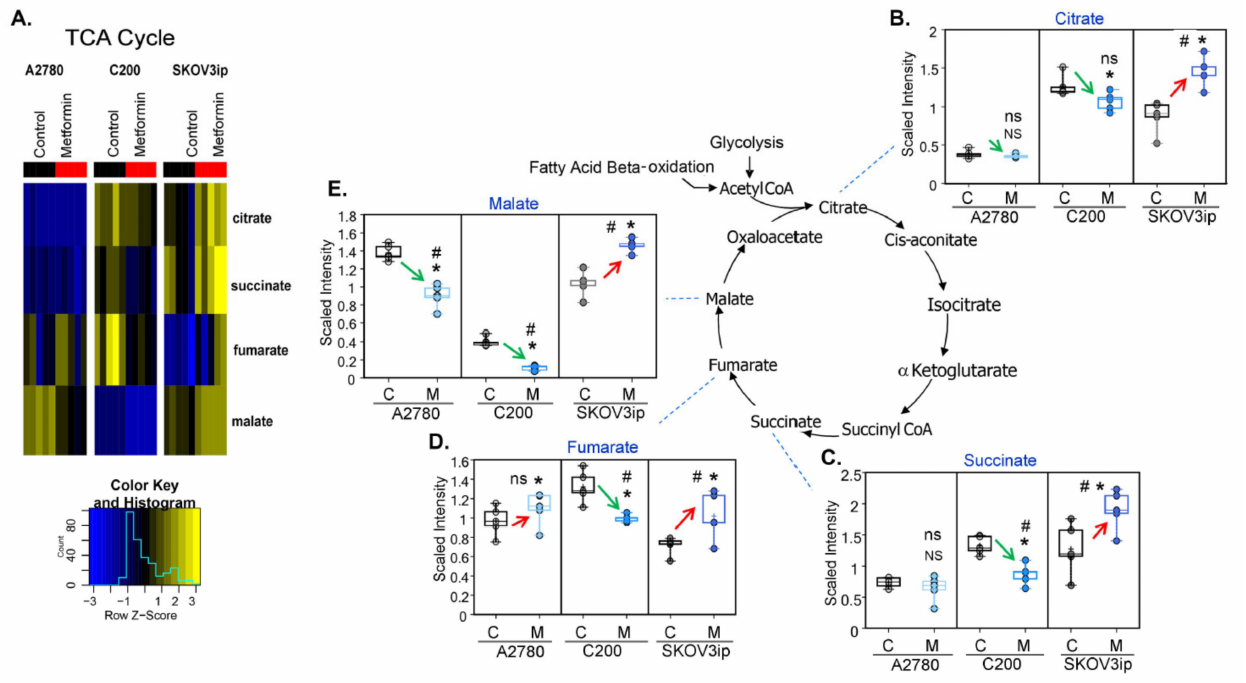
Figure 3. Effect of metformin on TCA cycle intermediates is cell-line specific. Selective analysis of TCA metabolites from the untargeted metabolomics was performed in untreated control (C) and 10 mM metformin (M)-treated cells. ( A ) Heatmap showing alterations in TCA cycle metabolites in A2780, C200, and SKOV3ip cells. Scaled metabolite intensity graphs showing levels of ( B ) citrate, ( C ) succinate, ( D ) fumarate, and ( E ) malate. For all box-plot graphs, * p ≤ 0.05, NS = p non-significant, # q ≤ 0.05, ns = q non-significant when metformin treated compared to